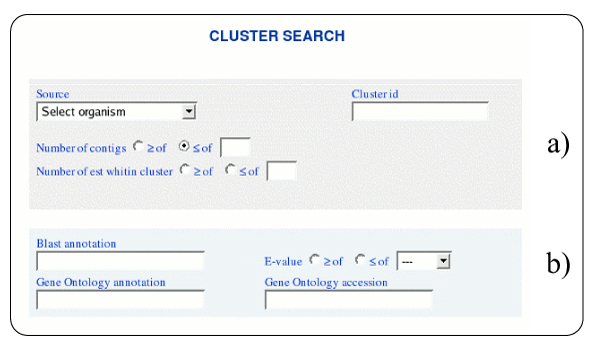
A screenshot of the CLUSTER Browser. Clusters can be retrieved using their identifier in the database and their structural features (a); functional annotation can be included in the query (b).